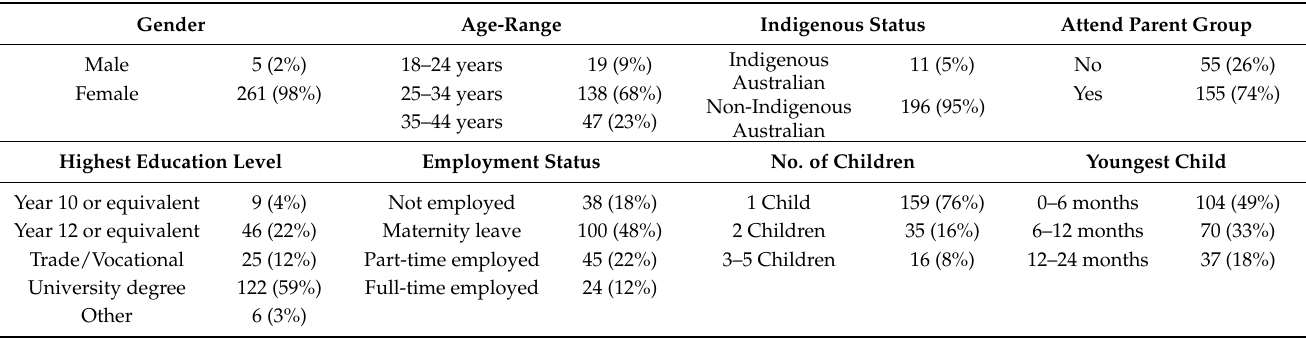
Table 1. Parent/Care giver demographic characteristics of participants in the PICNIC project (total n =